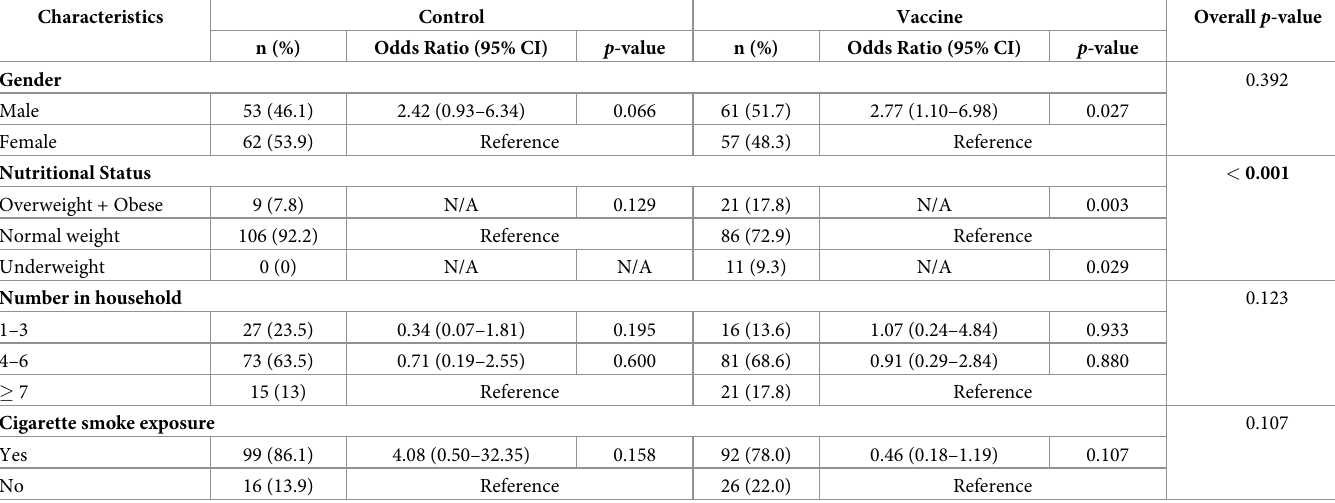
Table 1. Demographic characteristics by cohort